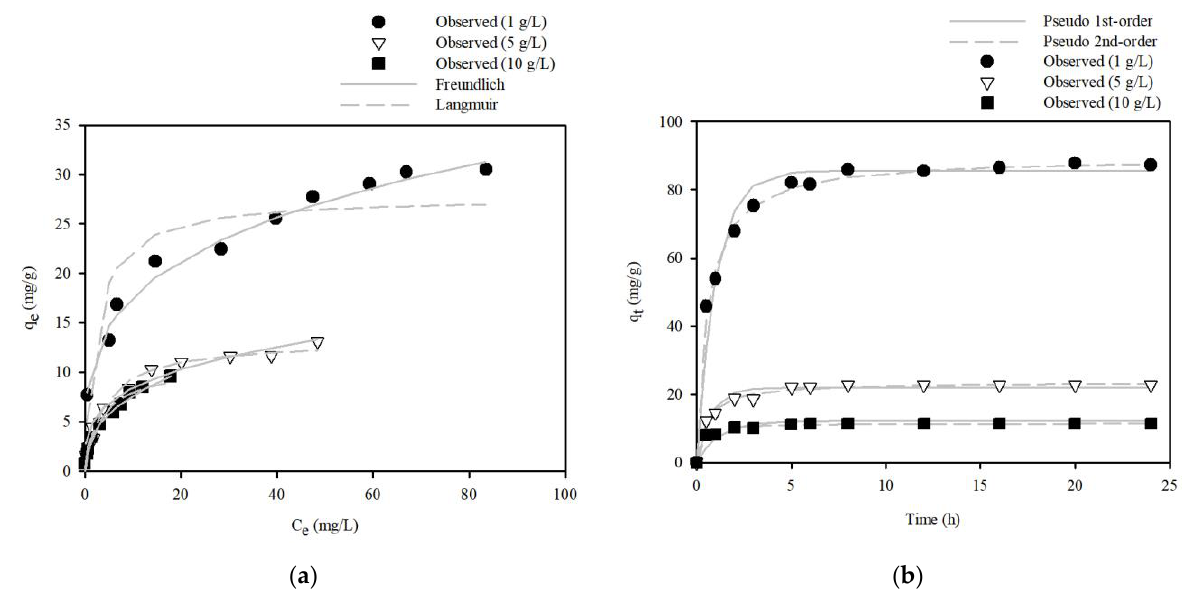
Figure 8. ( a ) Adsorption isotherm of Pb( Ⅱ ) onto the S.P@Ca-SA, and ( b ) Pb( Ⅱ ) adsorption kinetics fitted by pseudo-first-order and pseudo-second-order models onto the S.P@Ca-SA. Table 2. Equilibrium isotherm model parameters obtained from model fitting to experimental data. Freundlich Model Adsorbent Dose (g/L)